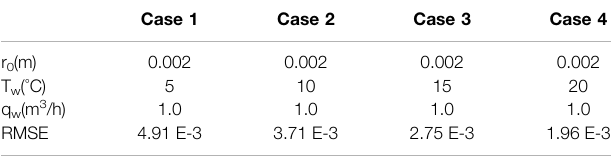
TABLE 4 | RMSE value at different water temperature, for Example three.